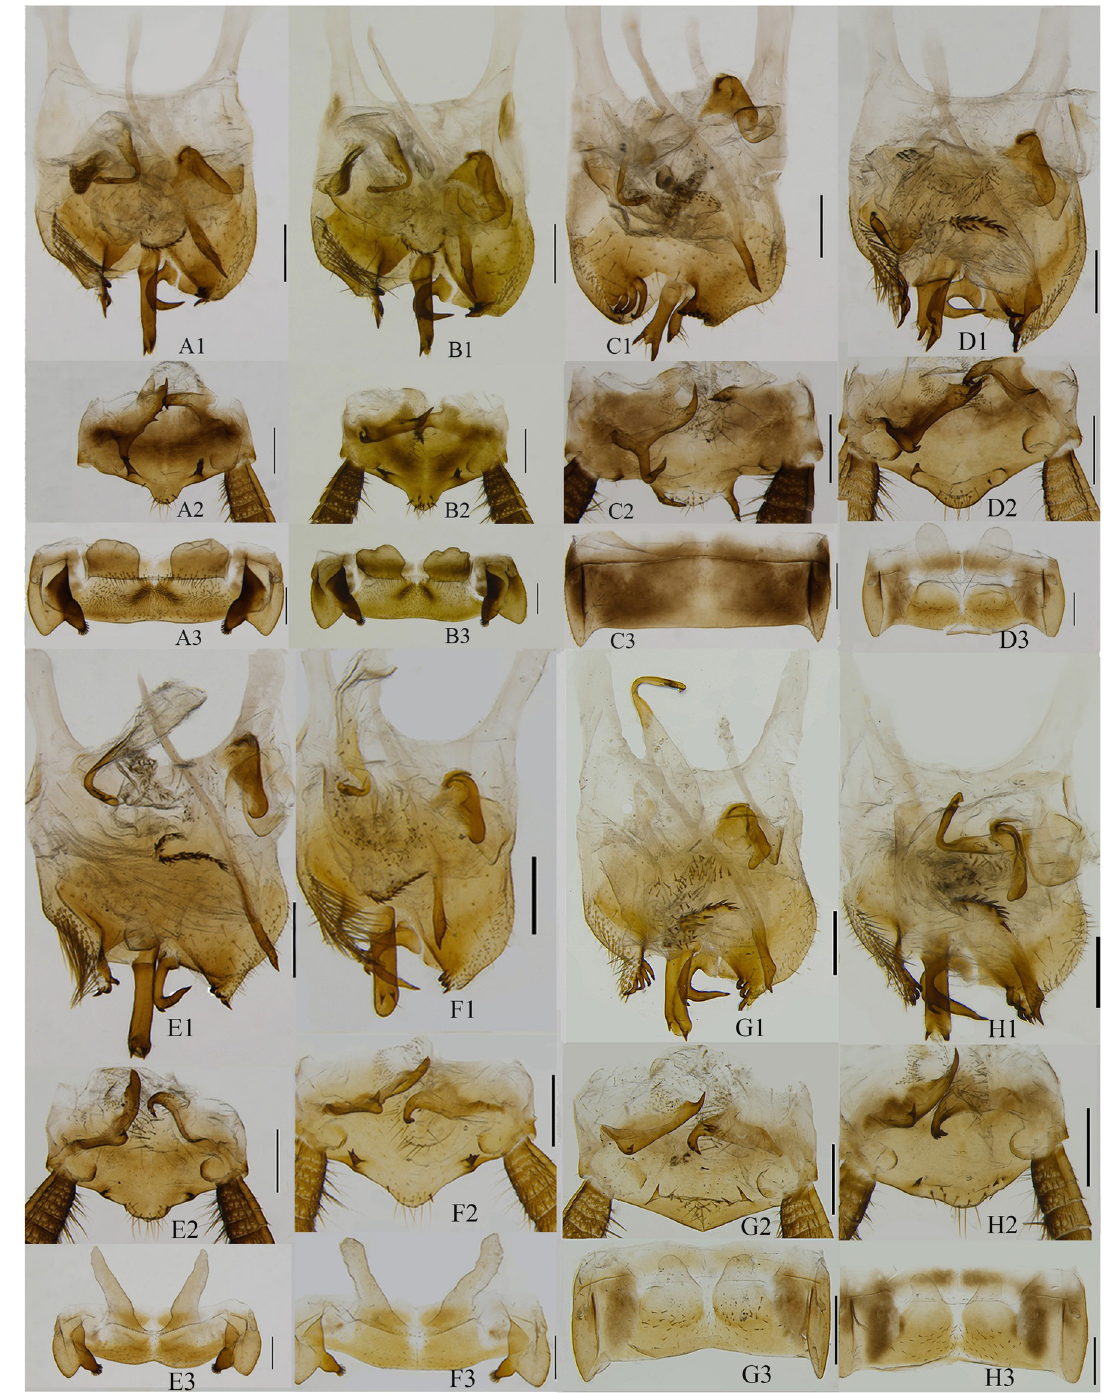
Fig 3. Male genitalia. Sigmella puchihlungi : A1–A3 (voucher c1DLS2), B1–B3 (voucher cJFL4). S . normalis sp. nov.: C1–C3 (voucher aWZS2). S . exserta sp. nov.: D1–D3 (voucher dSTS4). S . digitalis sp. nov.: E1–E3 (voucher bBWL1). S . digitalis sp. nov.: F1–F3 (voucher bLPC1). Sigmella schenklingi biguttata : G1–G3 (voucher eGP4), H1–H3 (voucher eSS2). A1–H1: subgenital plate, dorsal view; A2–H2: supra-anal plate, ventral view; A3–H3: the seventh abdominal tergum, ventral view. Scale = 0.5cm.